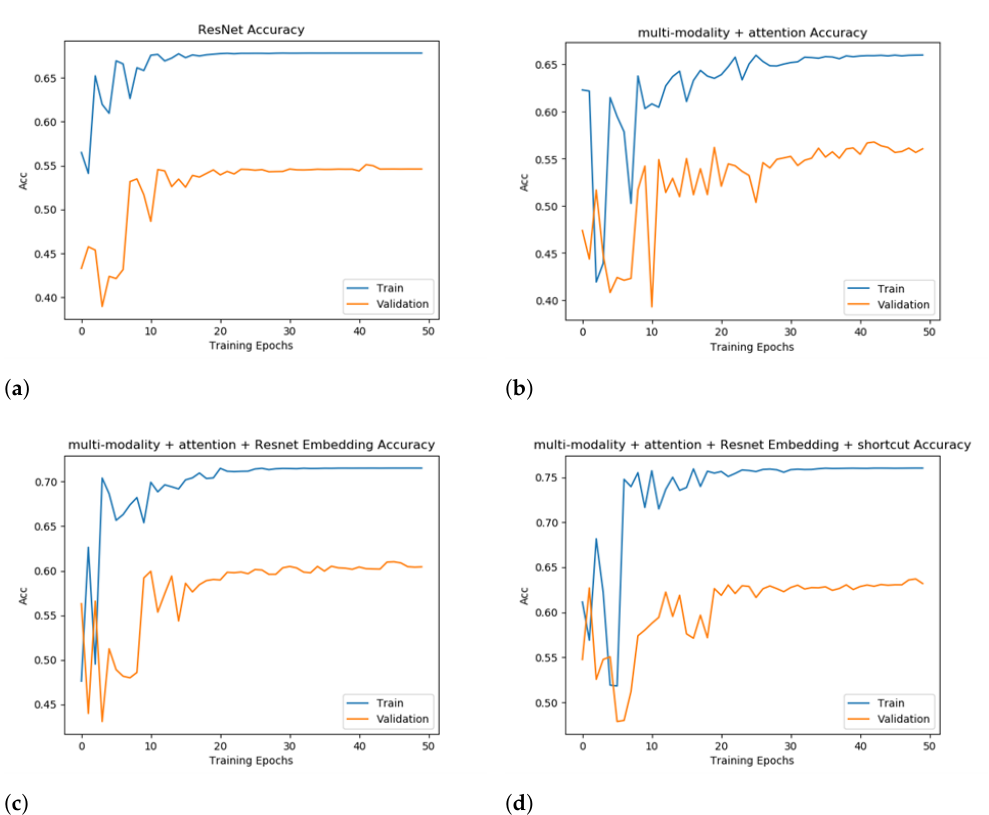
Figure 5. Training and validation accuracy to show an ablation study. Subfigures ( a – d ) represent the four evaluated models with a booster added incrementally to the previous